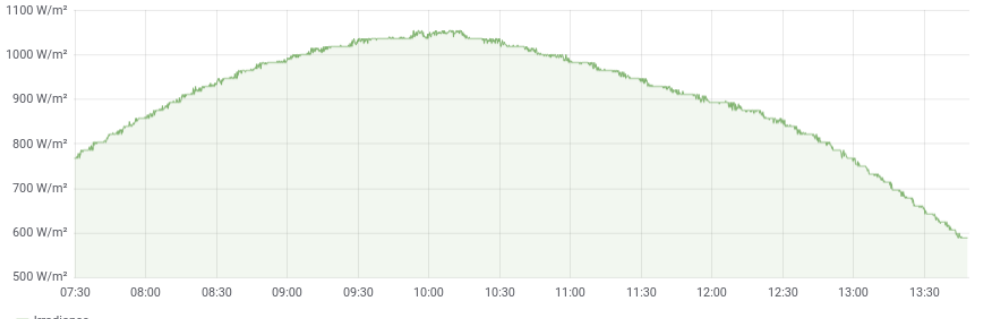
Figure 6. Irradiance ( I )